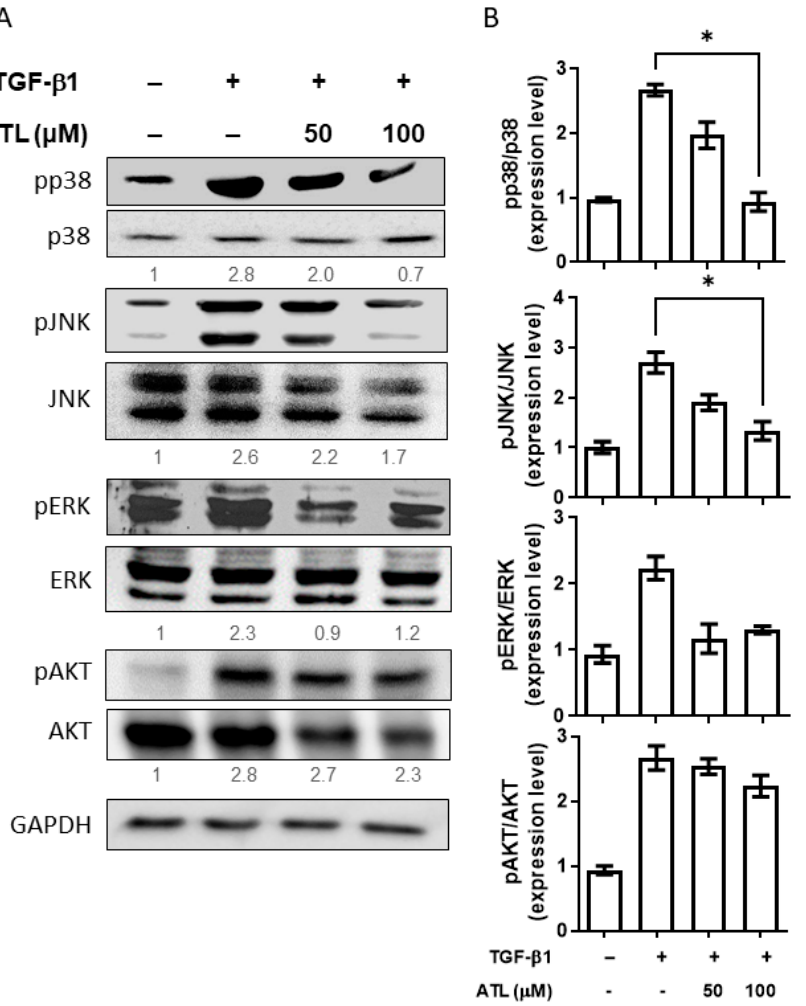
Figure 5. Atractylodin reduced Smad-independent pathway activated by TGF- β 1 in A549 cells. A549 cells were pretreated with ATL for 1 h followed by TGF- β 1 (2 ng/mL) stimulation for an additional 6 h. Cells treated with DMSO were set up as the control group. ( A ) Protein expression levels of phospho- and non-phospho- p38, JNK, ERK, and AKT were measured by Western blot assay. ( B ) Quantitation of Western blot signal intensities by ImageJ software. Values represent the mean ± SEM from triplicate samples for each treatment. (*) p < 0.05 versus TGF- β 1 + 0.1% DMSO-treated control, as determined by non-parametric Kruskal–Wallis test and all pairwise multiple comparison procedures (Dunn’s Method).